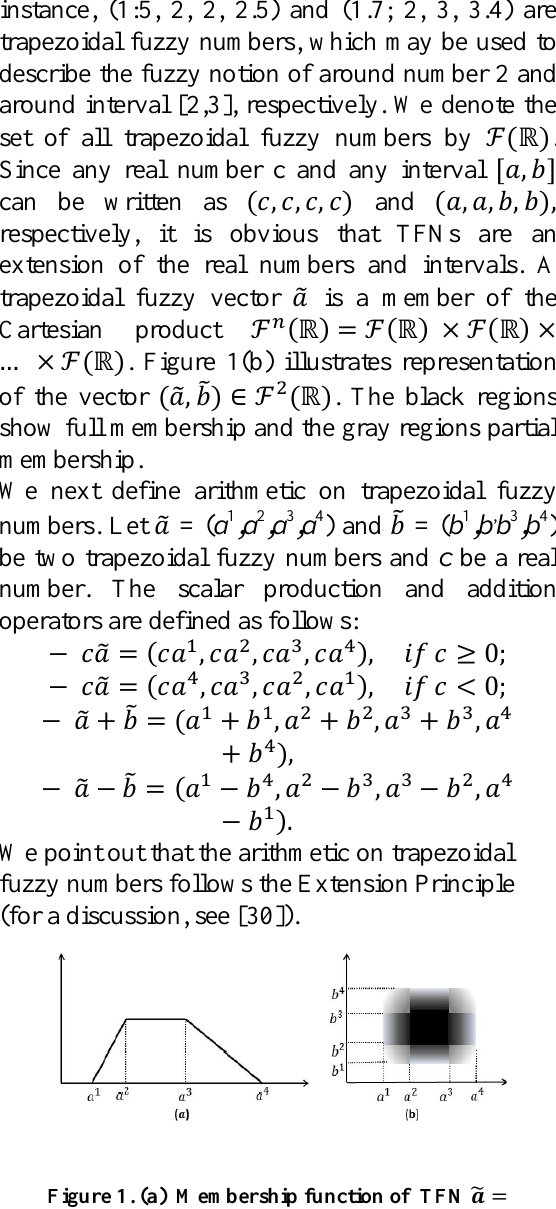
Figure 1. (a) Membership function of TFN ̃ , (b) Representation of ( ̃ ̃)